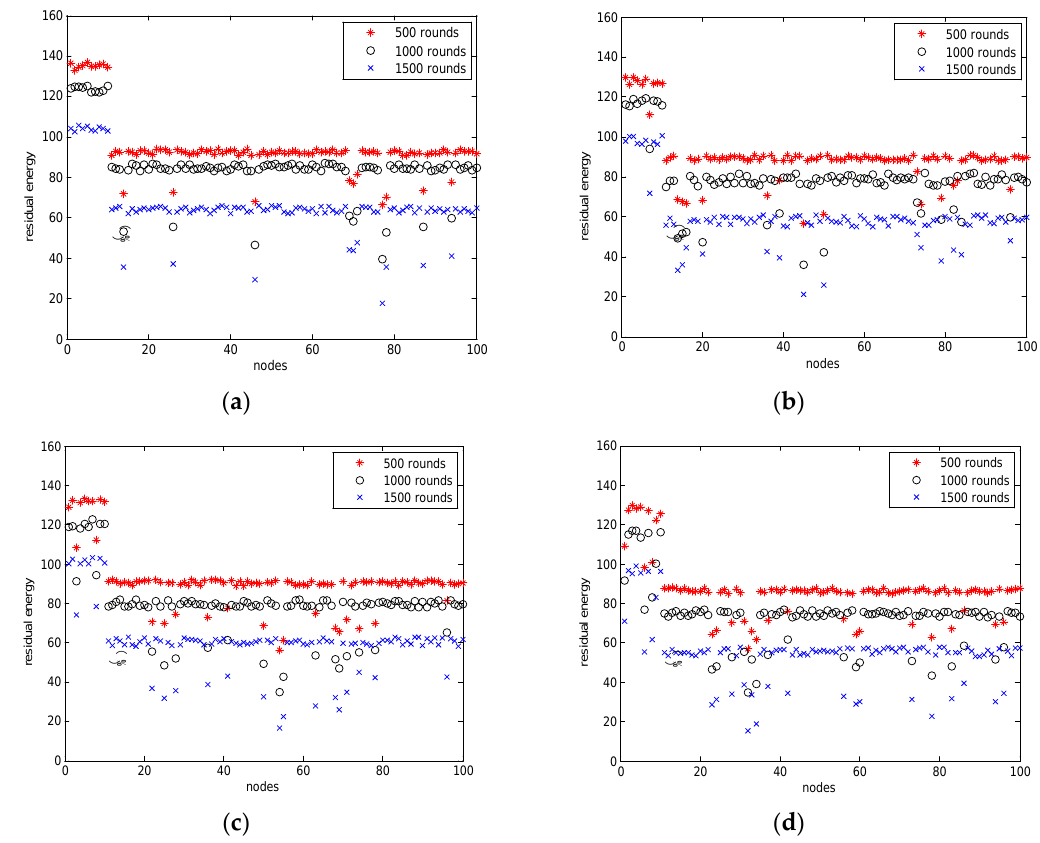
Figure 2. ( a ) Residual energy in different rounds in scenario 1. ( b ) Residual energy in different rounds in scenario 2. ( c ) Residual energy in different rounds in scenario 3. ( d ) Residual energy in different rounds in scenario 4.